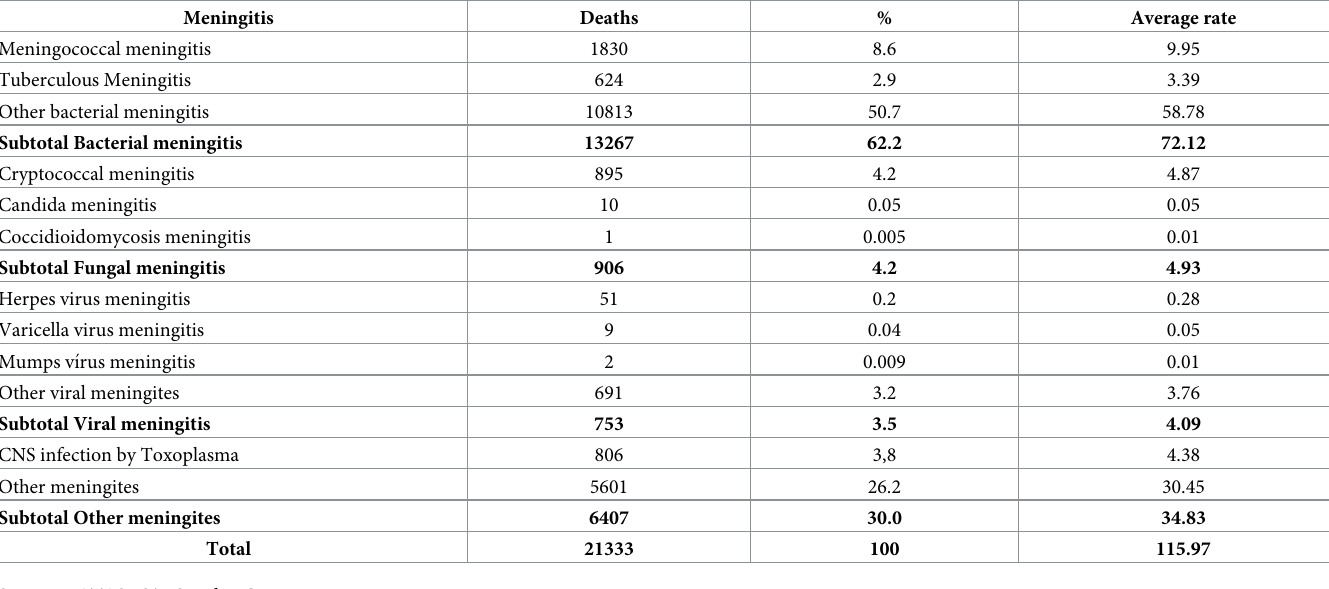
Table 4. Deaths and mean mortality rates � for cryptococcal meningitis and other meningitis. Brazil, 2000 to 2012.